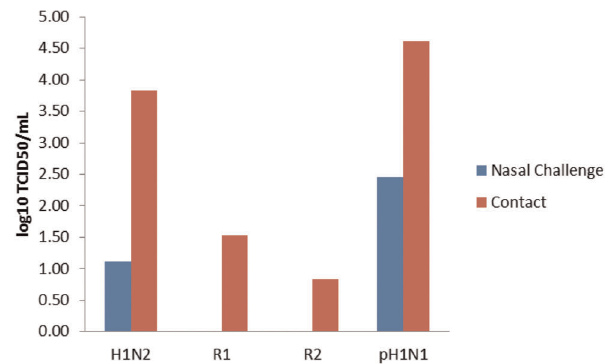
Figure 7. Lung samples were collected on day five post infection and analyzed for TCID50 by virus replication assay in ST cells. Data represent the mean log 10 TCID 50 /mL for the four lung samples per treatment group. Samples with different subscripts within the same treatment group are statistically different (P ,